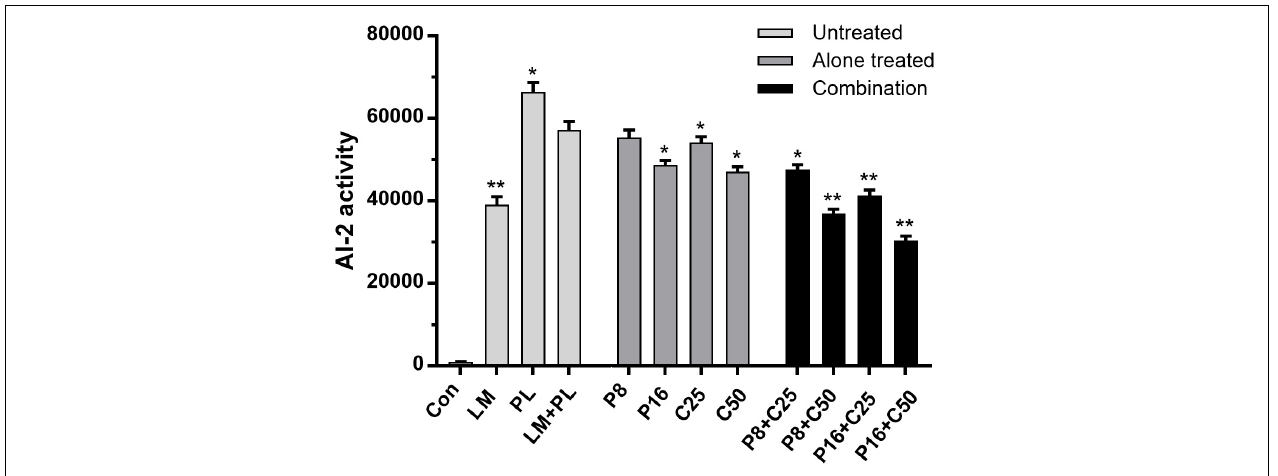
FIGURE 4 | Effects of ε -PLH combined with CEO on the AI-2 activity of L. monocytogenes and P. lundensis as co-culture. Data were expressed as mean ± standard deviations ( n = 3). * p < 0.05; ** p < 0.01: significant interspecies